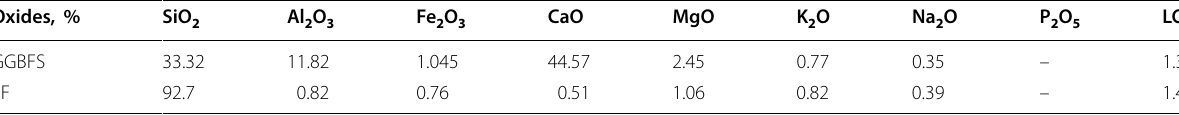
Table 2 Elemental composition of GGBFS and SF.